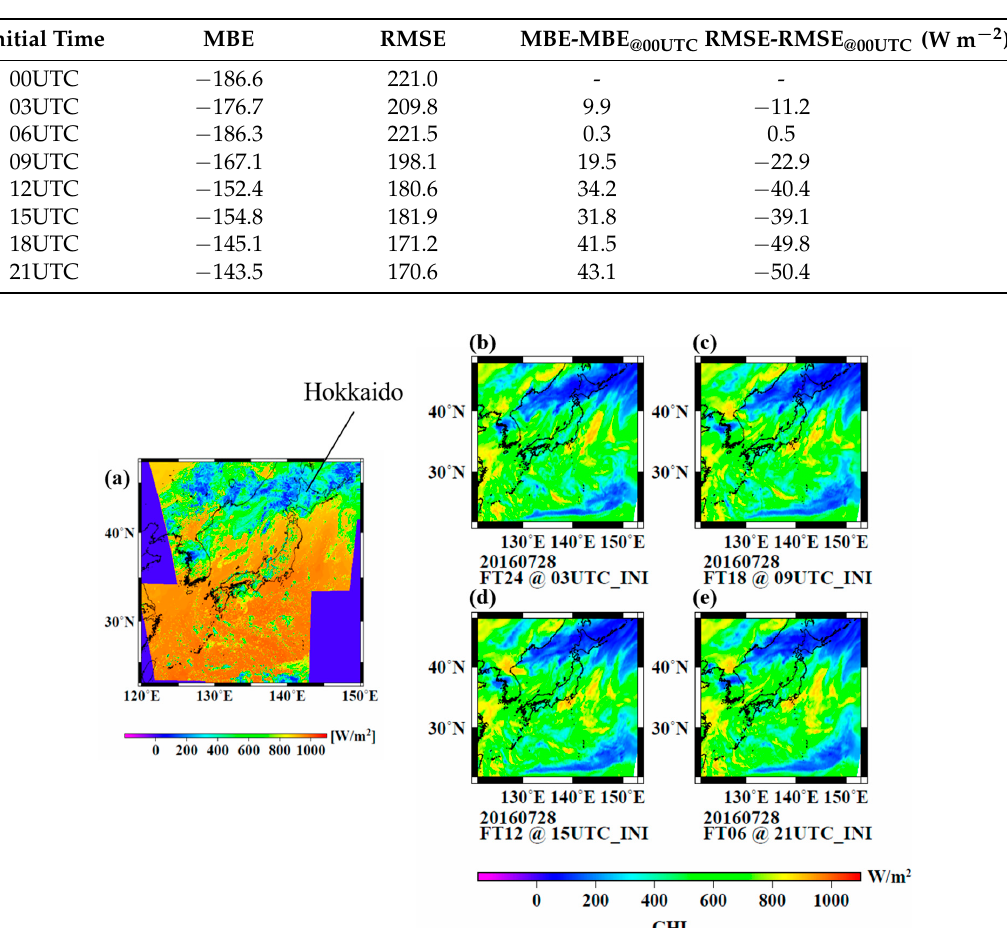
Figure 9. ( a ) Satellite-estimated GHI (AMATERASS data) at 12 JST on 29 July 2016. MSM GHI forecasts of ( b ) 24-h forecasts with initialization time of 03 UTC on 28 July, ( c ) 18-h forecasts with initialization time of 09 UTC, ( d ) 12-h forecasts with initialization time of 15 UTC and ( e ) 6-h forecasts with initialization time of 21 UTC.